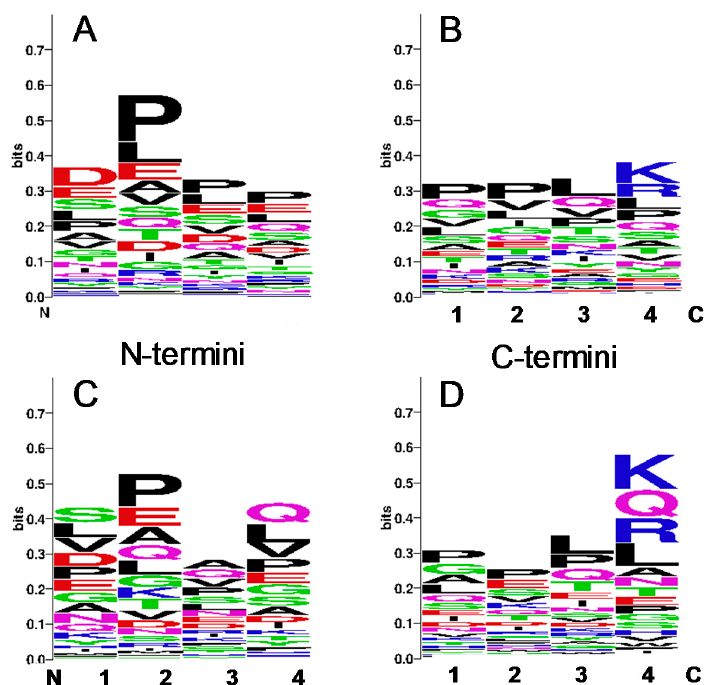
Figure 6. Structure of N- and C-terminal cleavage sites dependent on the storage condition. Amino acid sequences of peptides detected in samples immediately frozen at − 80 °C ( A , B ) or stored for 24 h at RT ( C , D ). Analysis was performed via WebLogo v. 2.8.2. The overall height of the stack indicates the sequence conservation at that position, while the height of symbols within the stack indicates the relative frequency of each amino acid at that position.